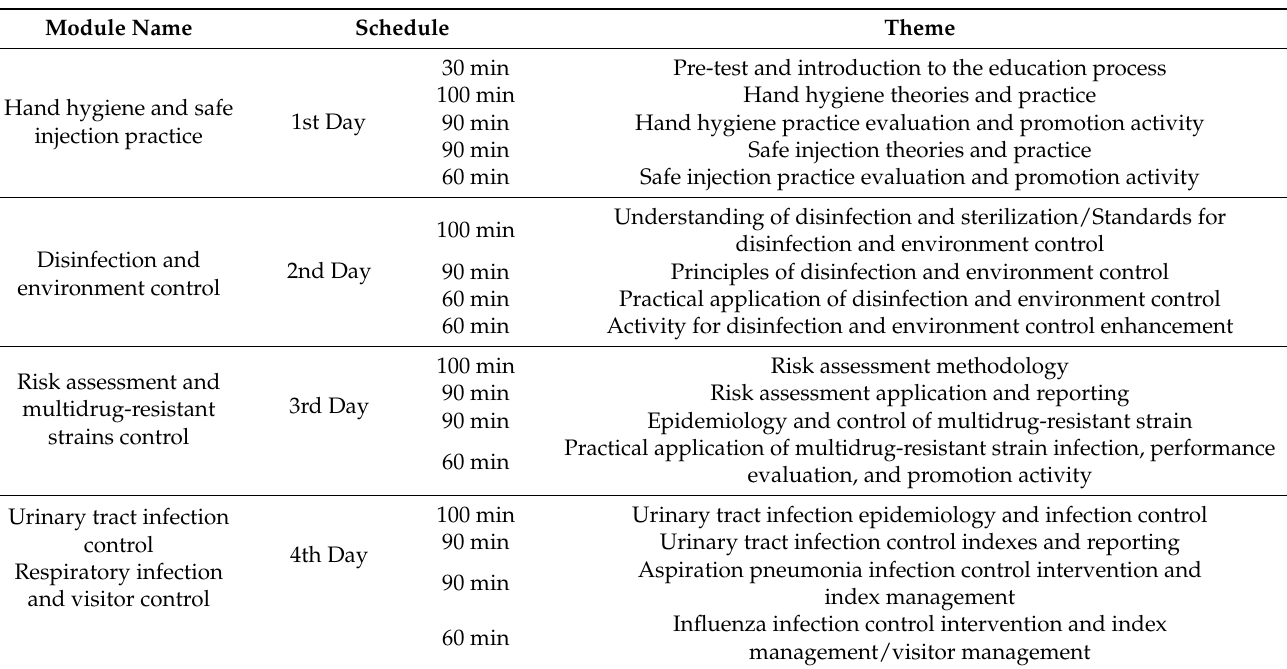
Figure 1. Educational-training programme modules based on the identified key tasks using the DACUM method. This figure shows that five modules were developed to teach the knowledge and skills needed to perform nine key tasks. For example, the “risk assessment and multidrug- resistant strains control” module was developed to teach knowledge and skills required for “MRSA infection control”, “scabies control”, and “preparing for the Korean accreditation program for health- care organizations.” ICP, Infection Control Practitioner; LTCH, Long-term Care Hospital; MRSA, methicillin-resistant Staphylococcus aureus ; DACUM, Developing A Curriculum. Table 3. Educational-training programme for infection control practitioners in long-term care hospi- tals based on the DACUM